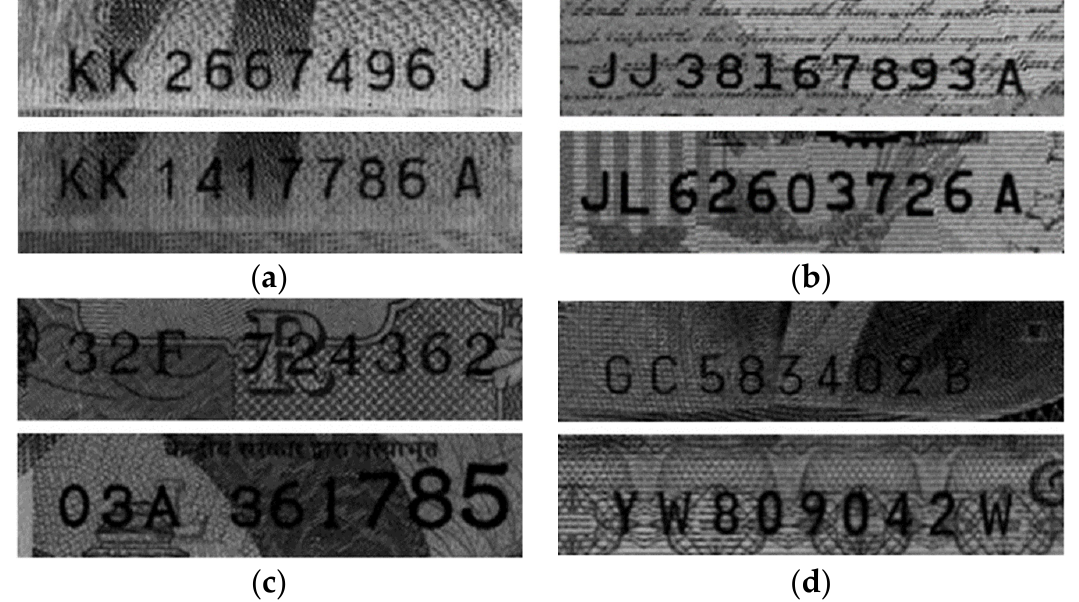
Figure 5. Examples of cropped ROI images for each currency: ( a ) KRW; ( b ) USD; ( c ) INR; ( d ) JPY. When a note is inserted into the banknote counter, slight rotation and translation oc- cur. Additionally, banknotes with frequent circulation are subjected to soiling and creases.